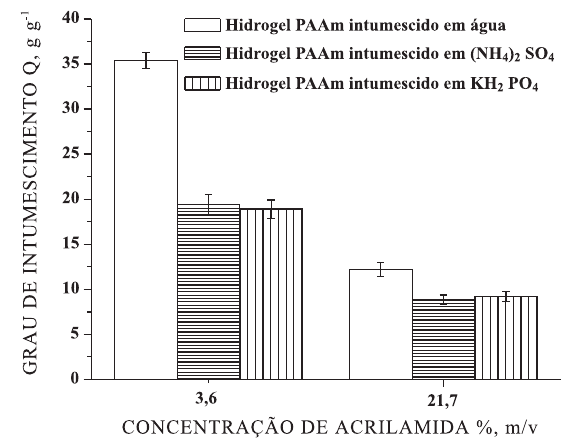
Figura 1. Dependência do grau de intumescimento em função da concentração de acrilamida para os hidrogéis